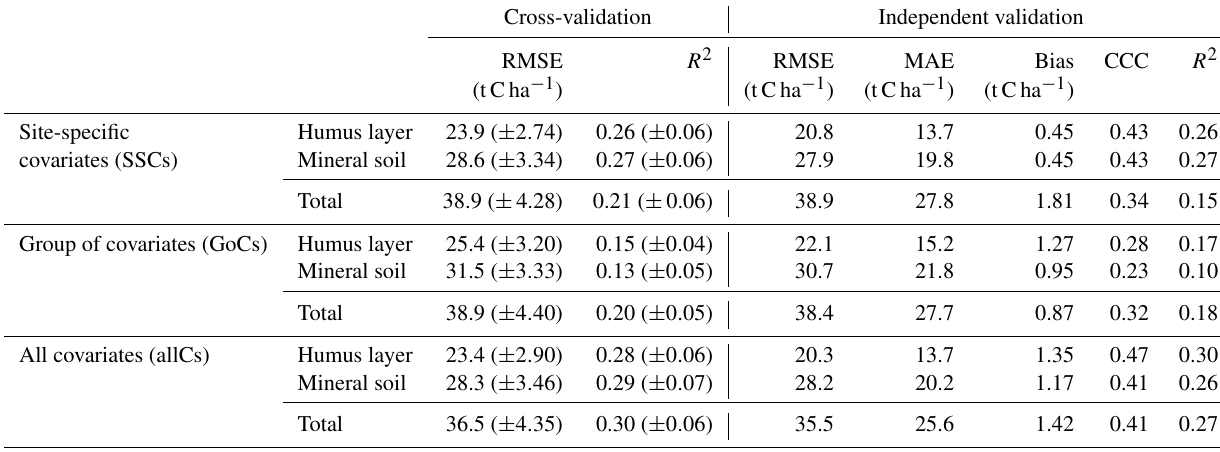
Table 3. Cross-validation and independent validation of the global random forest models at the national scale.